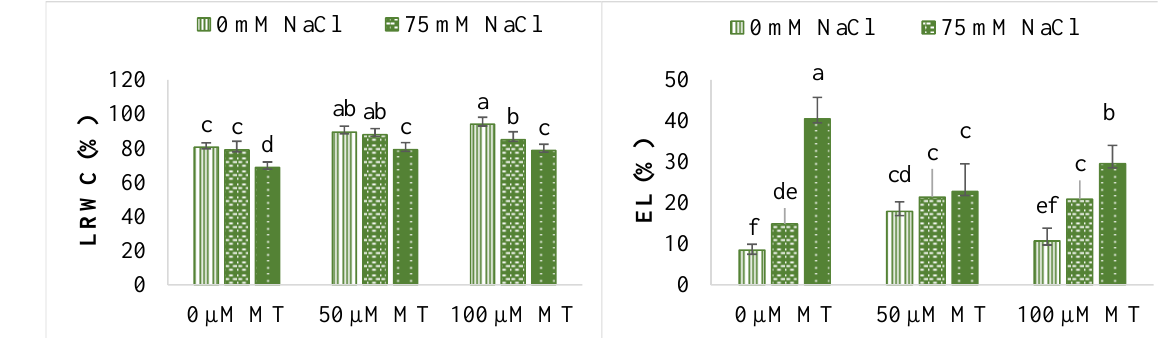
Figure 2. The LRWC and EL response in the leaves of the chickpea seedlings under salinity stress to MT applications. The means followed by a different letter on the bars were significantly ( p < 0.001) different according to Duncan’s multiple range test. Table 3. H 2 O 2 , MDA, proline, sucrose, CAT, POD, and SOD activity response in the leaves of the chickpea seedlings under salinity stress to MT